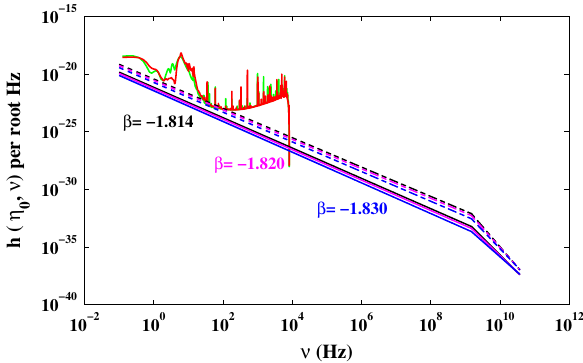
Fig. 1 The spectrum of RGWs in usual case ( solid lines ) and thermal case( dashedlines )comparedtotheHanford( greenline )andLivingston ( red line ) sensitivity